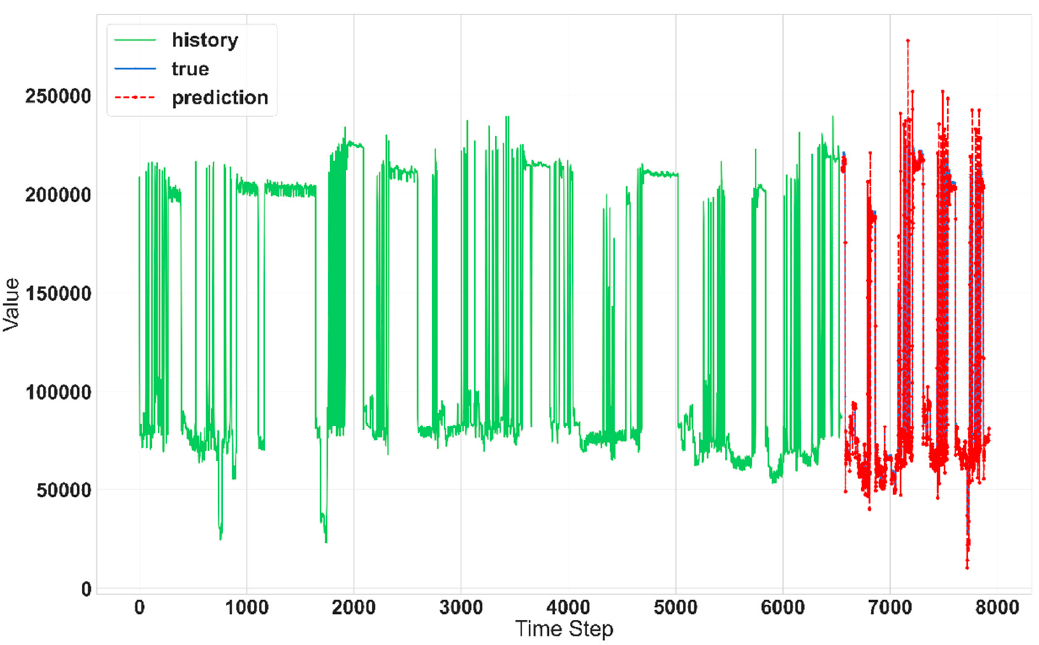
Figure 5. Actual and predicted data: green—training data (history), blue—test data (true), dotted